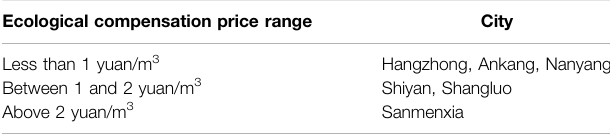
TABLE 7 | Average ecological compensation price of core cities in water source area in 2020~2022. Ecological compensation price